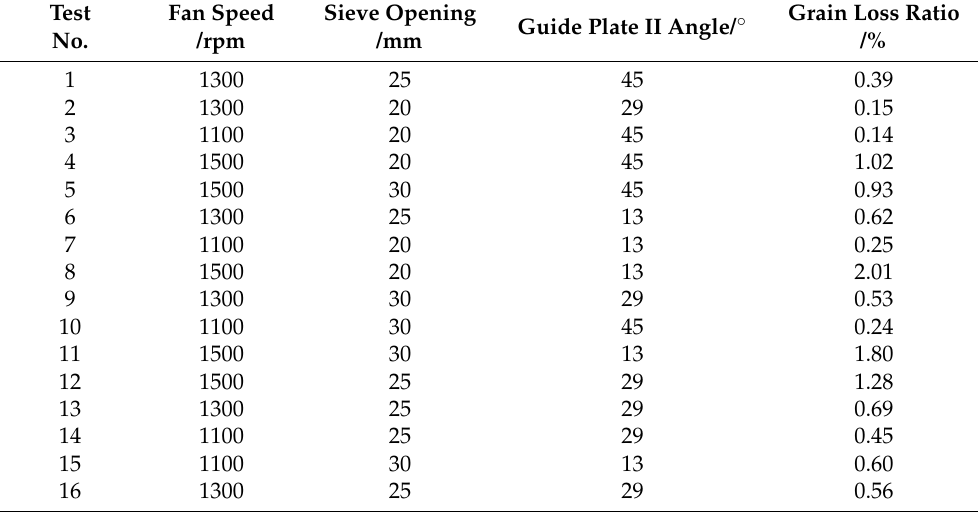
Table 3. Surface response experimental results with respect to cleaning